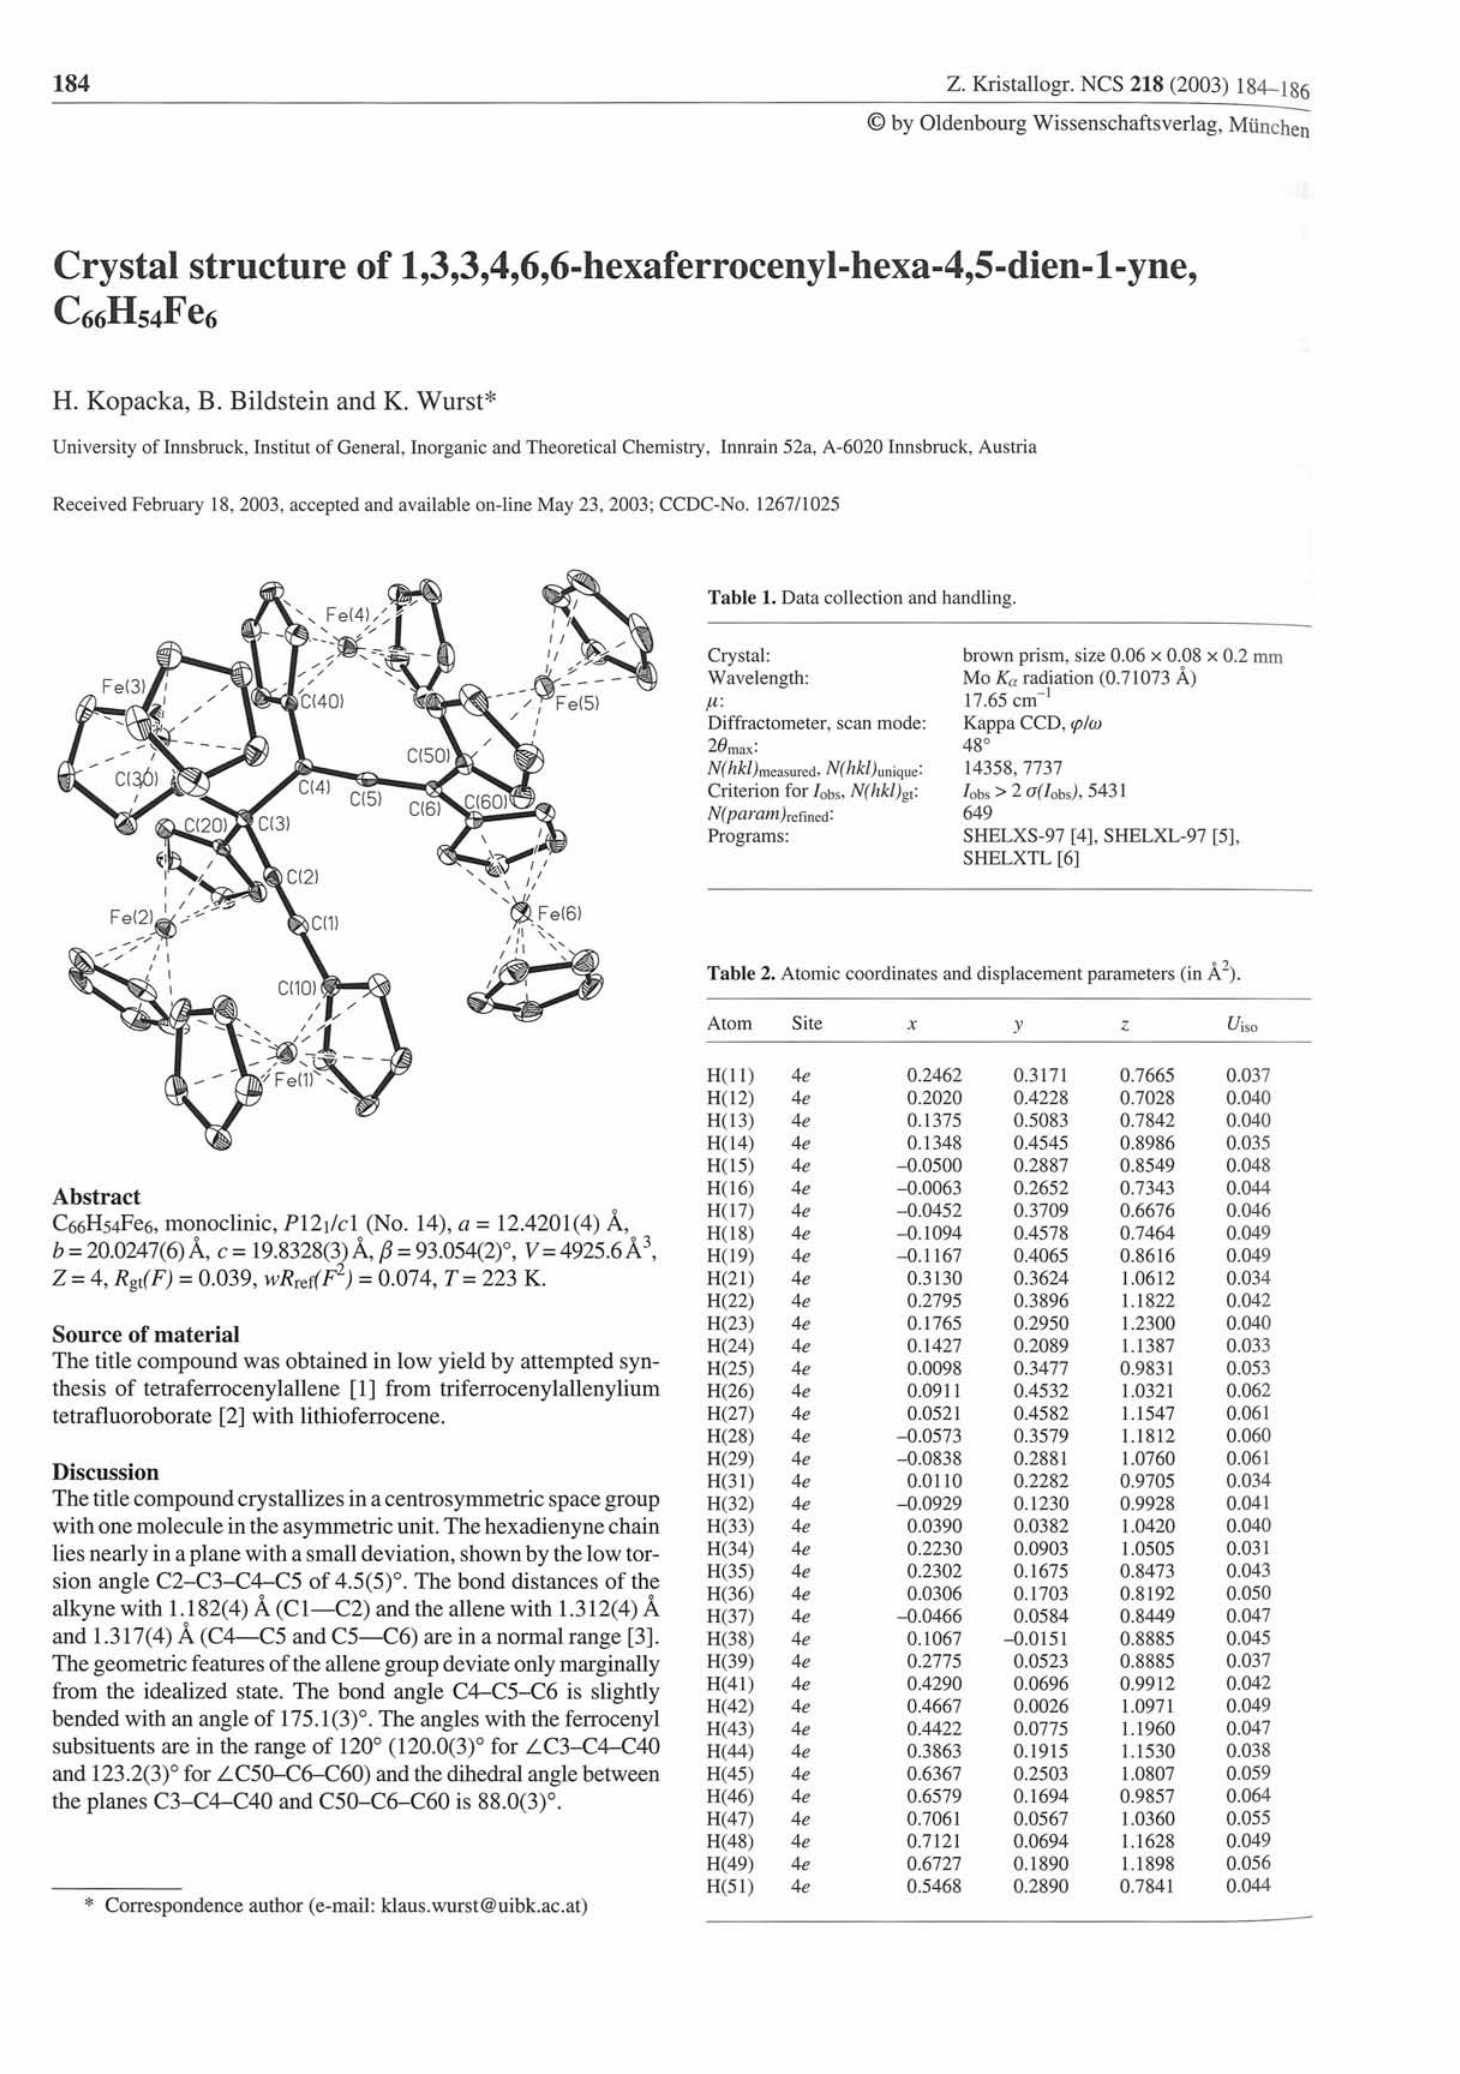
Table 1. Data collection and handling.